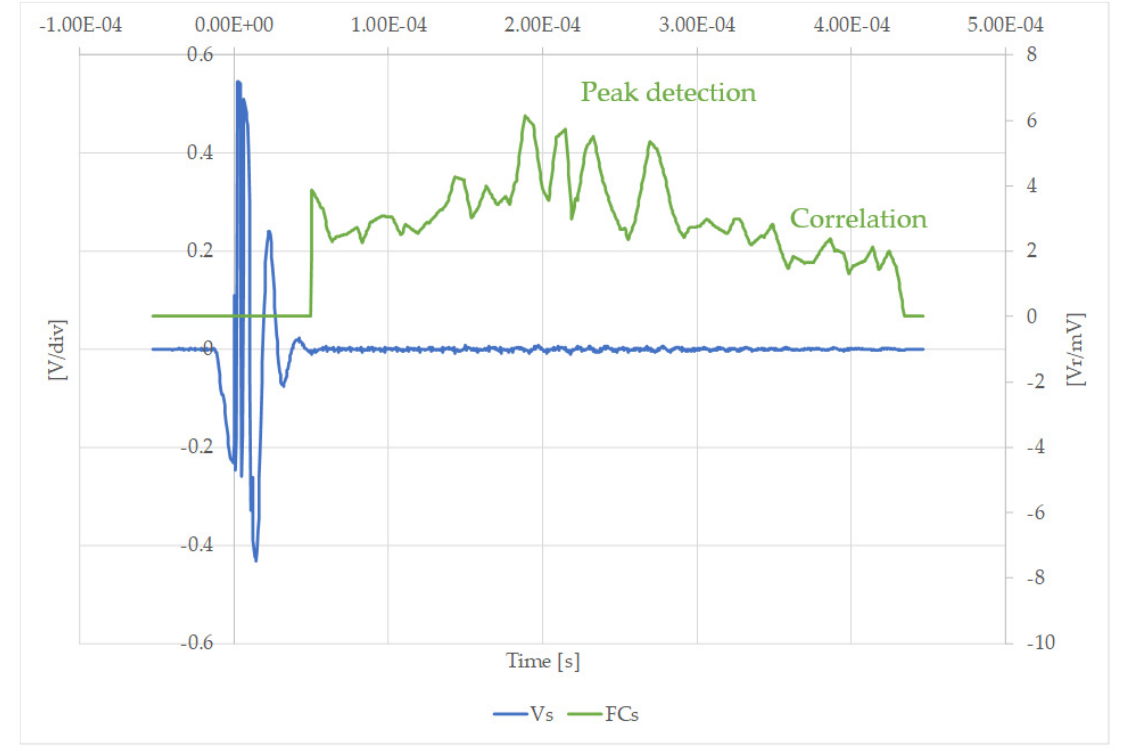
Figure 18. Measured, Vs [V / div], and filtered signal, FCs [Vr / mV], after using the correlation filter in the case of a total cement blockage at position B.